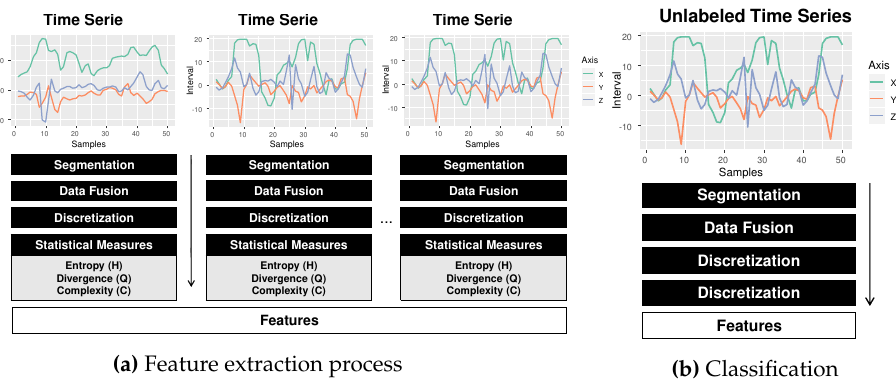
Figure 9. ( a ) The feature extraction process adopted by the HAR-SR method. ( b ) To classify a new non-labeled series T u , the procedure is similar to that performed in the training phase. The difference is that there is no need to obtain new reference